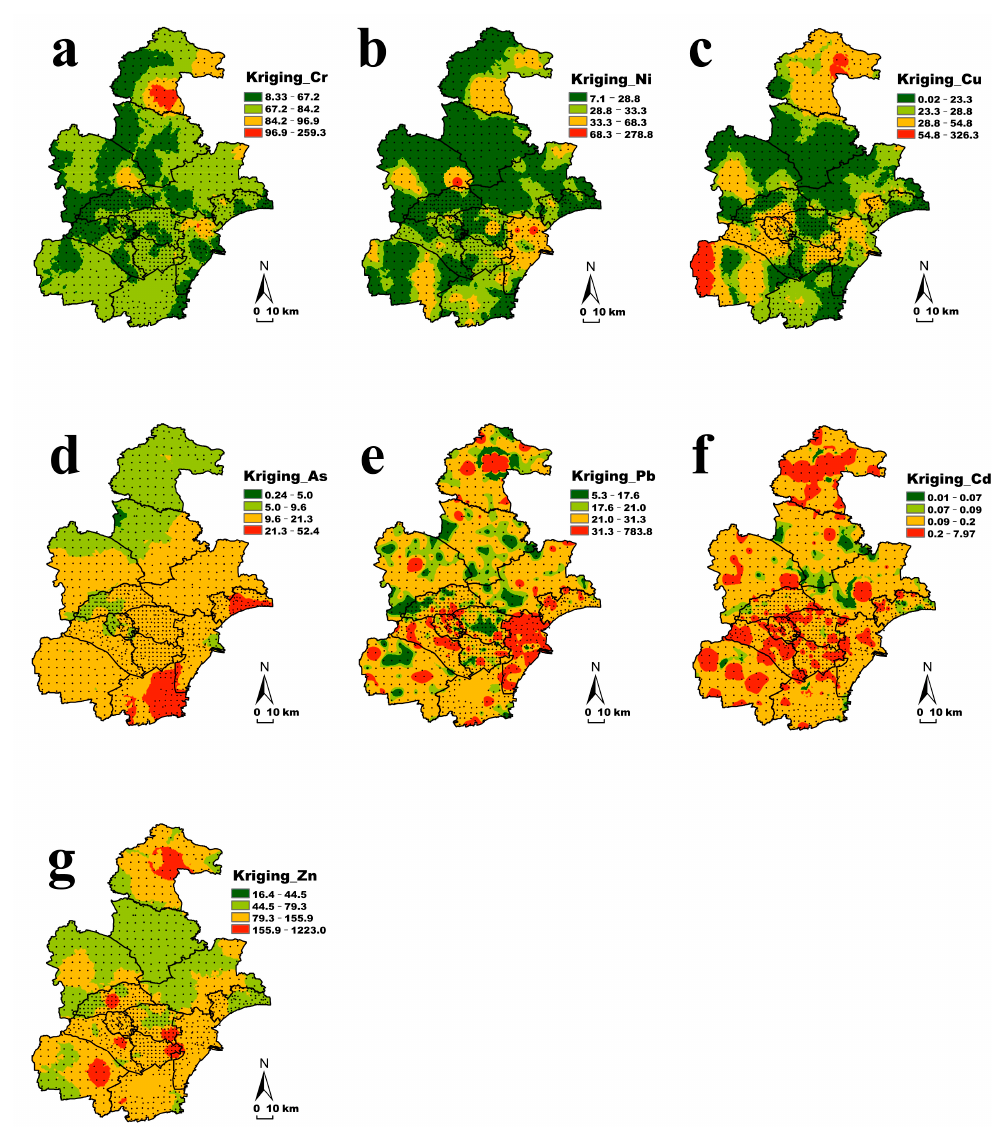
Figure 2. Spatial distributions of seven heavy metals ( a : Cr; b : Ni; c : Cu; d : As; e : Pb; f : Cd and g : Zn) in soils of Tianjin .